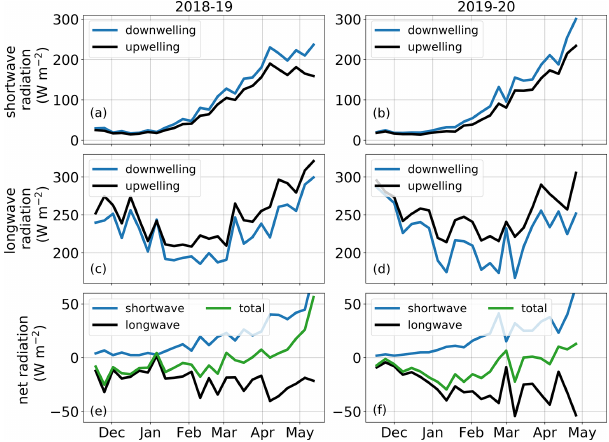
Figure 3. Measured radiation budget during the winters of 2018– 2019 (a, c, e) and 2019–2020 (b, d, f) . The upper panels (a, b) show the upwelling and downwelling shortwave radiation; the mid- dle panels (c, d) show the corresponding longwave components; and the lower panels (e, f) show the short, long, and total net radiation. Labeled tick marks on the x axis indicate the start of each